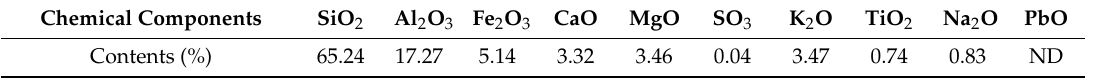
Table 2. Main chemical components of tested soil (expressed as oxides).